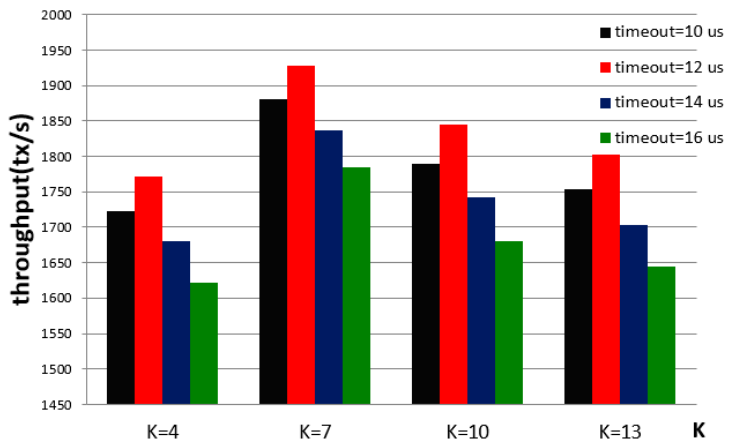
Figure 11. Throughput with various timeouts.